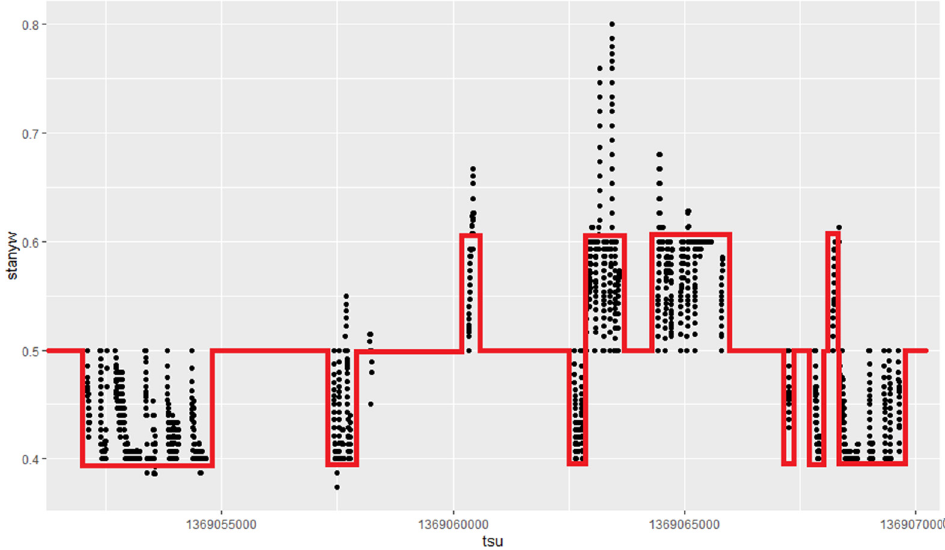
Figure 10. Changes in direction of shearer movement. Source: Own study.